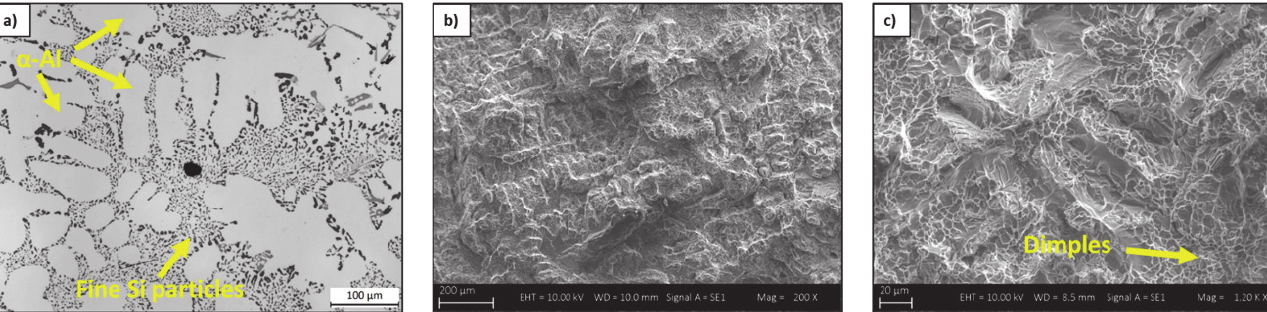
Figure 11: HPT6 50 treated specimen: (a) microstructure at high magnification by optical microscopy; (b-c) fracture surface by scanning electron